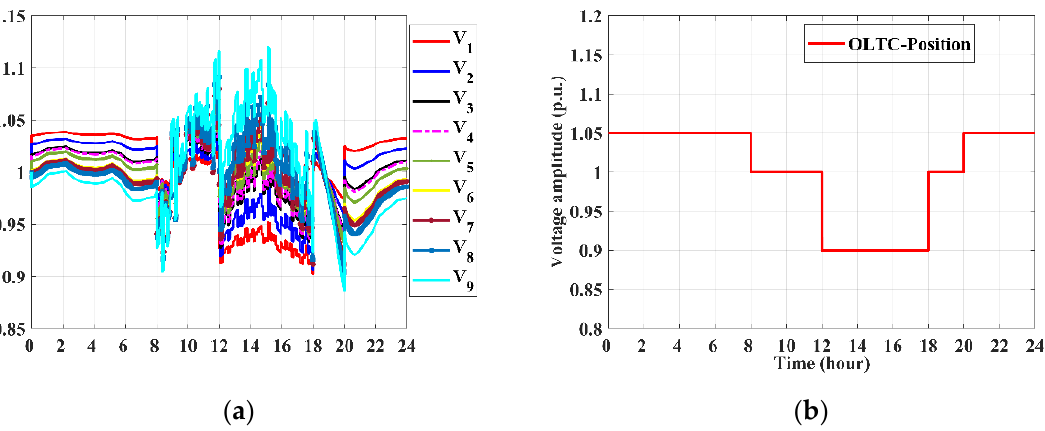
Figure 8. Node voltage fluctuation only with OLTC: ( a ) Nodal voltage fluctuation; ( b ) the tap position of OLTC.